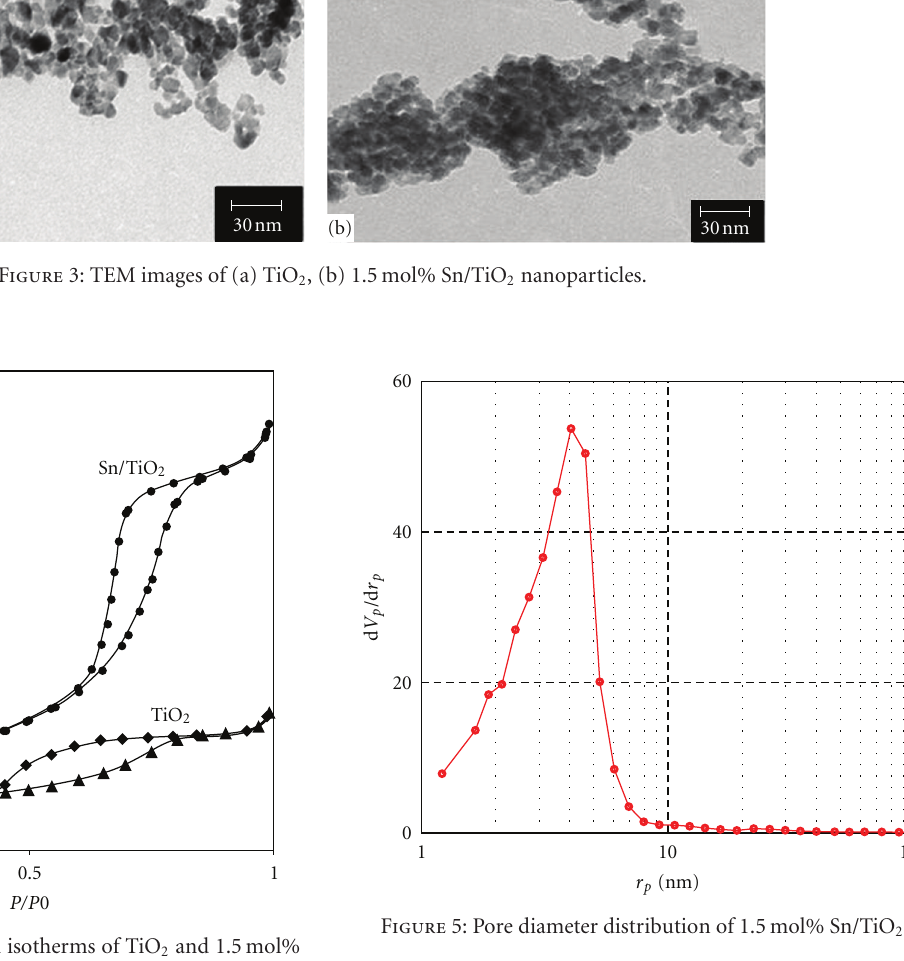
Figure 4: Adsorption-desorption isotherms of TiO 2 and 1.5 mol% Sn/TiO 2 .